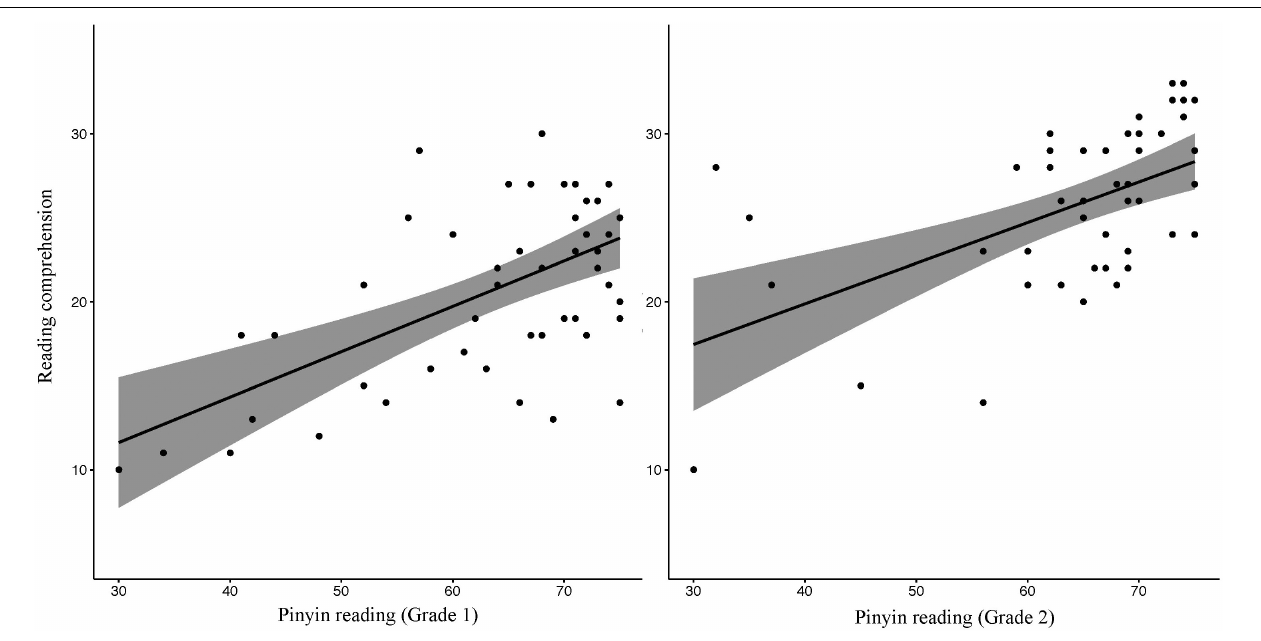
FIGURE 2 | Scatter plots of Pinyin reading against reading comprehension in Grades 1 and 2, respectively. For each plot, data points represented each as a black dot; regression trend represented as a black line and confidence intervals represented in shaded